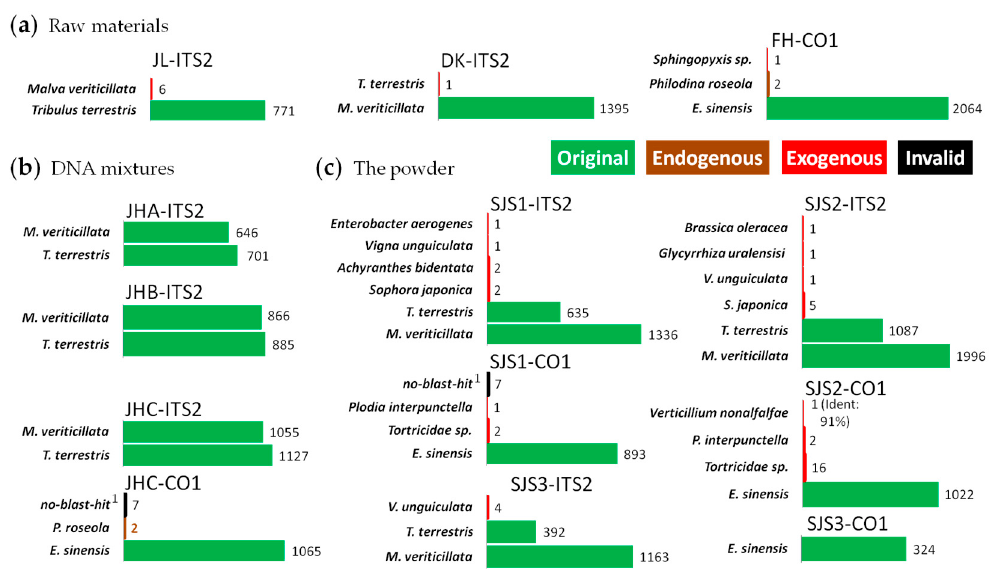
Figure 4. Analysis results on Sanwei-Jili-San by full-length multi-barcoding.